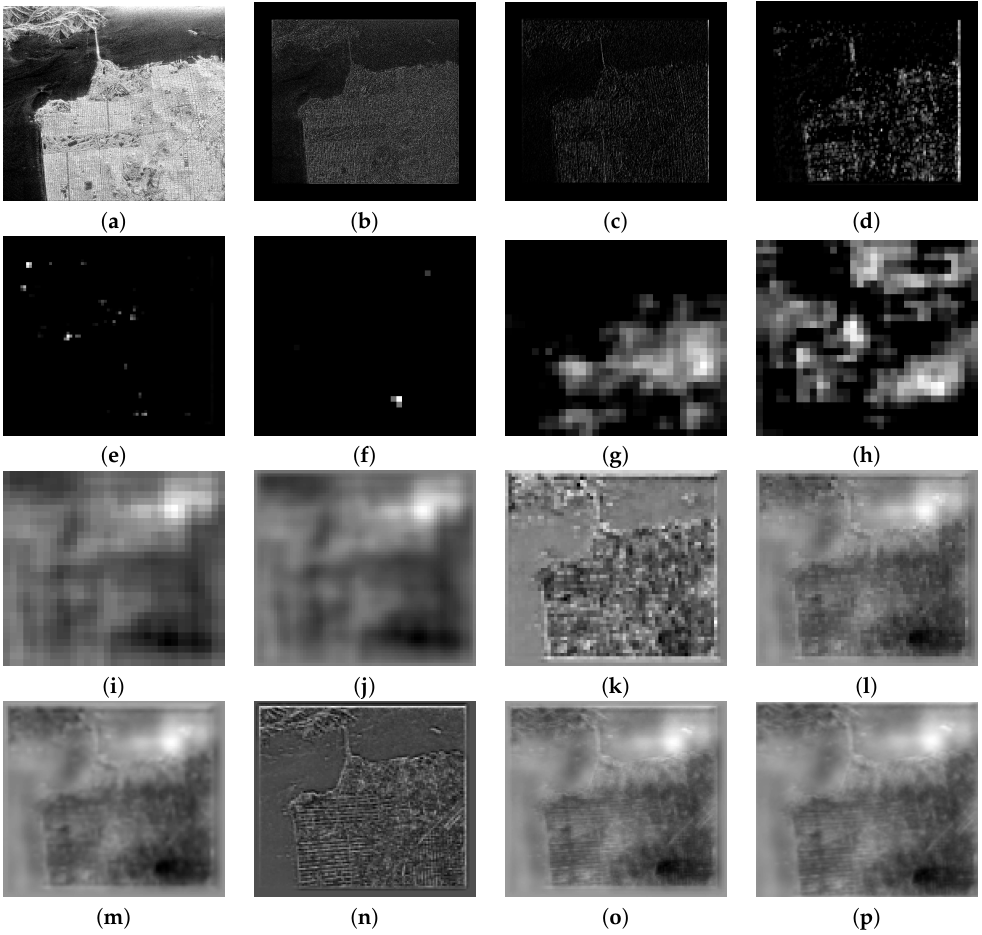
Figure 7. Visual feature maps in the first channel of specific layers of FCN-8s corresponding to Figure 6. ( a ) grayscale image of input layer; ( b ) pool1 layer; ( c ) pool2 layer; ( d ) pool3 layer; ( e ) pool4 layer; ( f ) pool5 layer; ( g ) fc6 layer; ( h ) fc7 layer; ( i ) score_fr layer; ( j ) upscore2 layer; ( k ) score_pool4c layer; ( l ) fuse_pool4 layer; ( m ) upscore_pool4 layer; ( n ) score_pool3c layer; ( o ) fuse_pool3 layer; ( p ) score